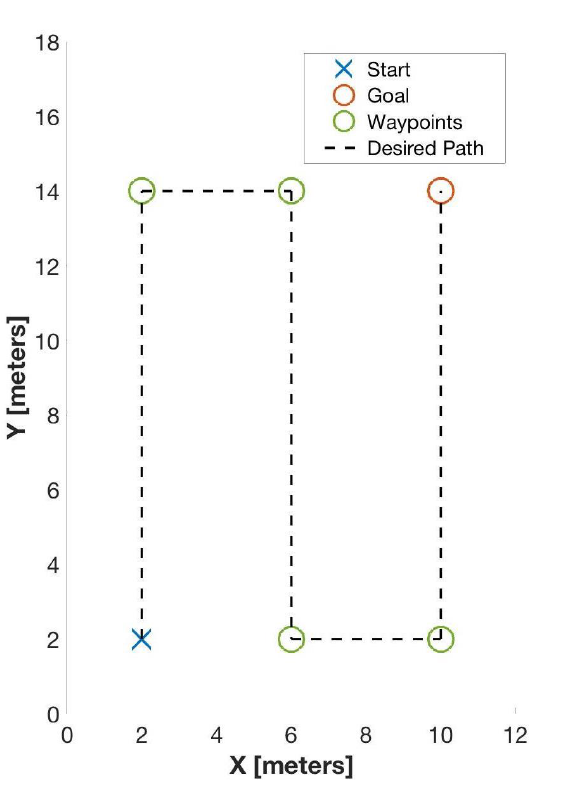
Figure 10. Testbed setup for Case Study III: A lawnmower pattern to perform seafloor mapping